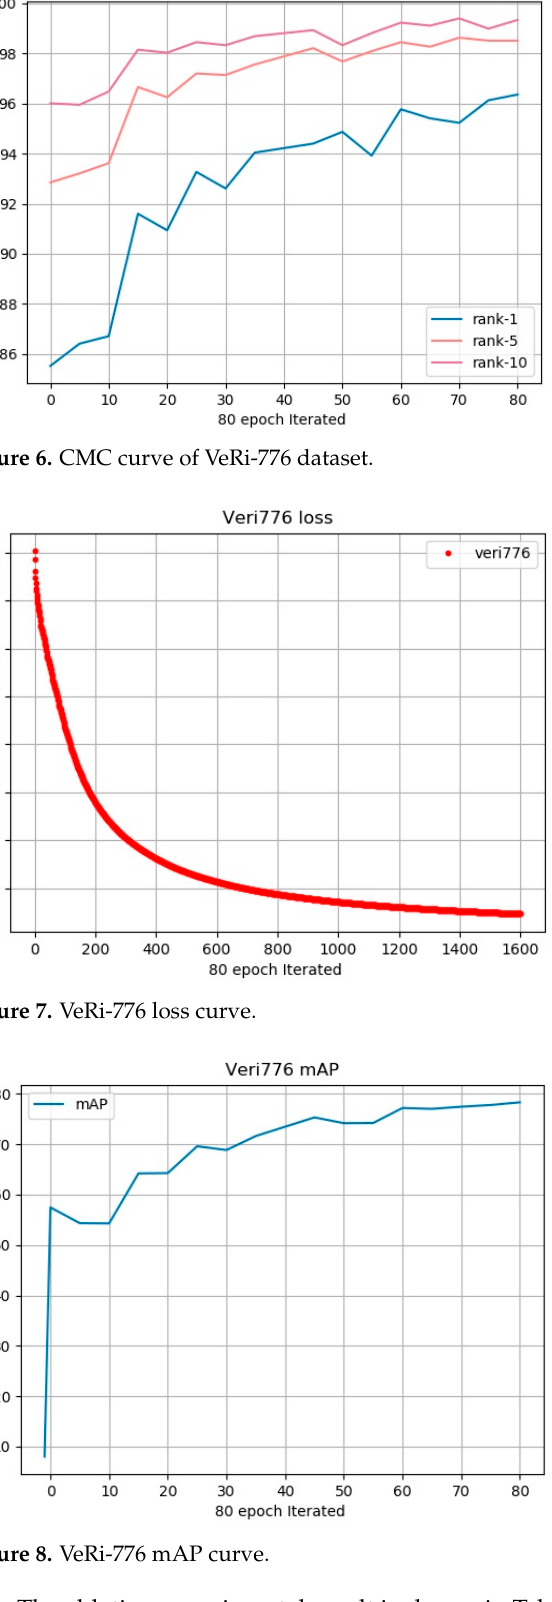
Figure 6. CMC curve of VeRi-776 dataset.